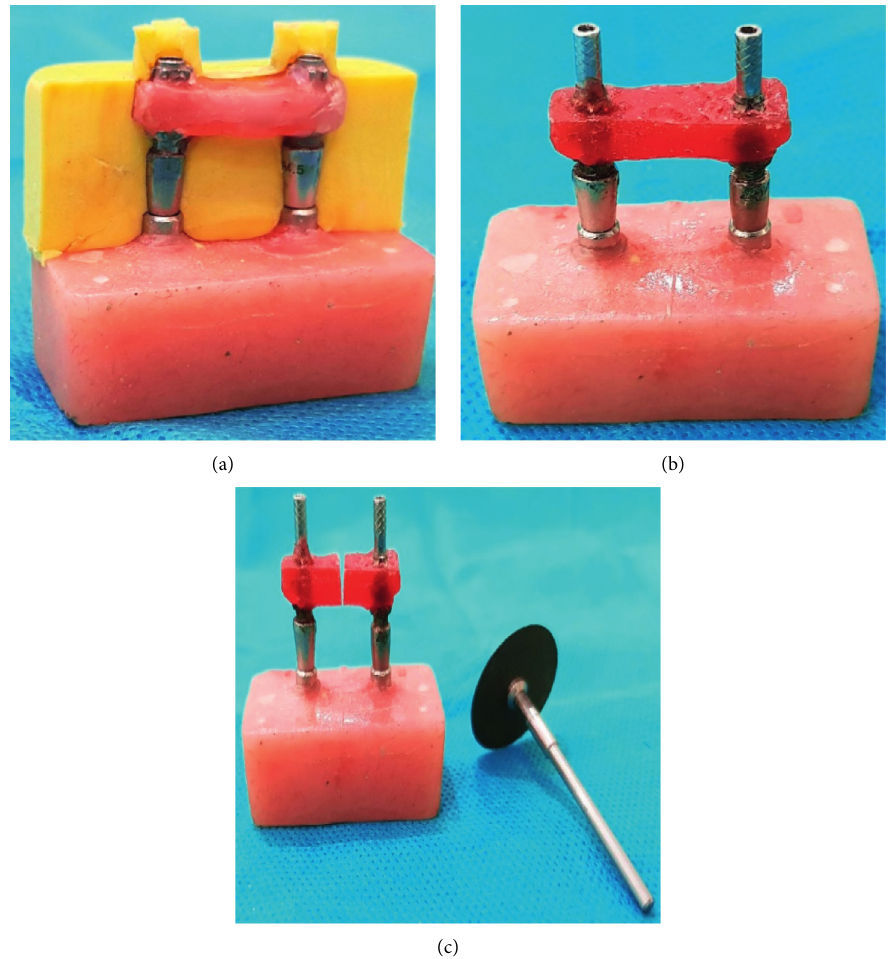
Figure 3: (a) Impression copings splinted with wax and the putty index prepared for controlling the volume of splinting material. (b) The impression copings splinted with autopolymerizing acrylic resin. (c) Sectioning the splinting material by using disk.